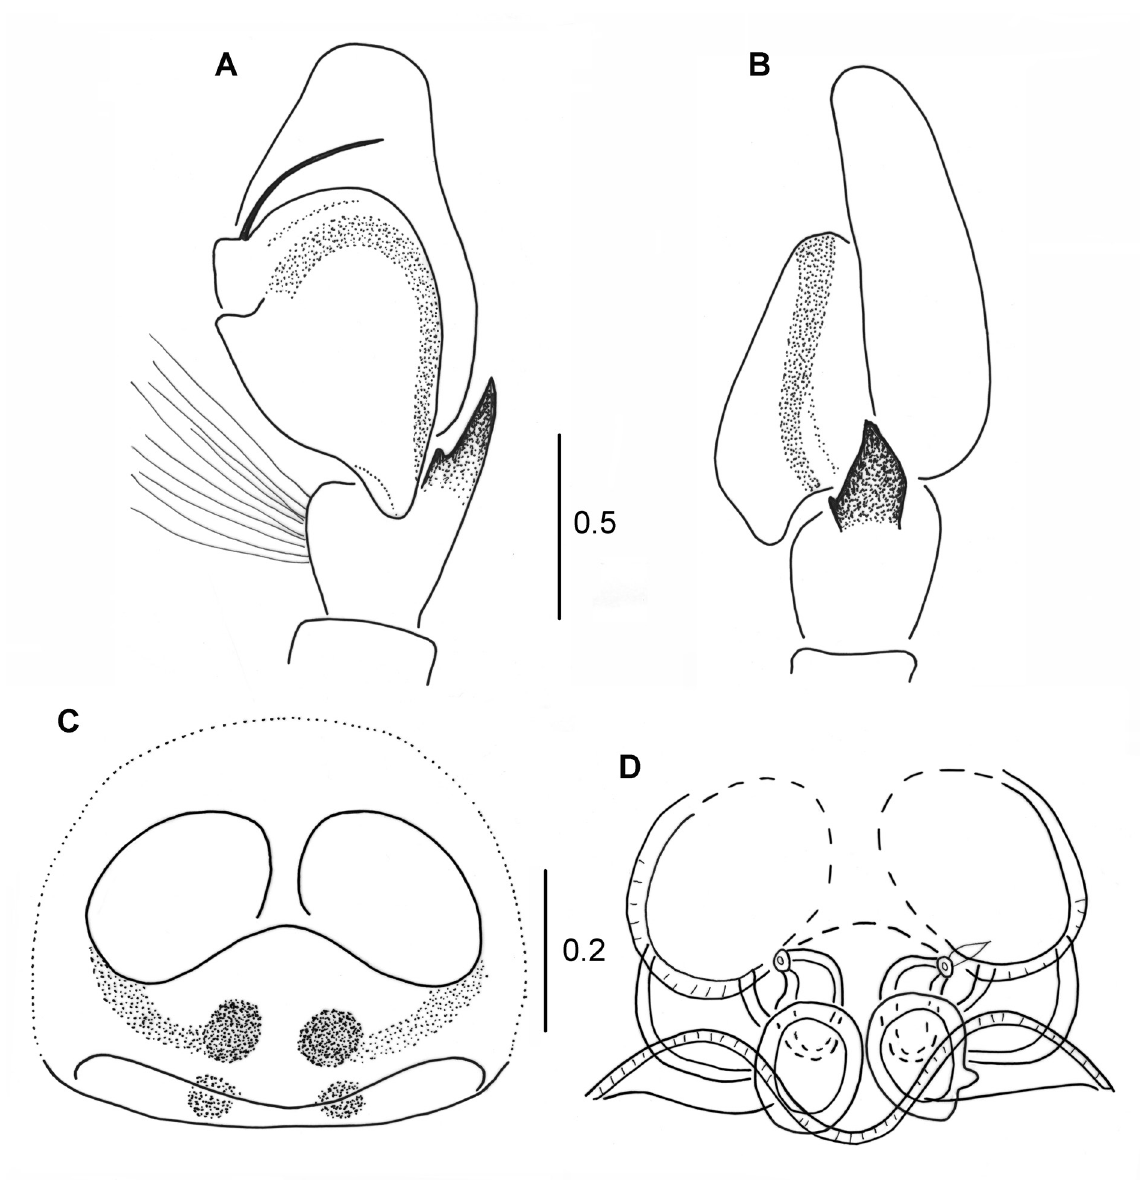
Fig. 78. Vicirionessa equestris (Simon, 1903) gen. et comb. nov., ♂♀ (MNHN). A . Palpal organ,